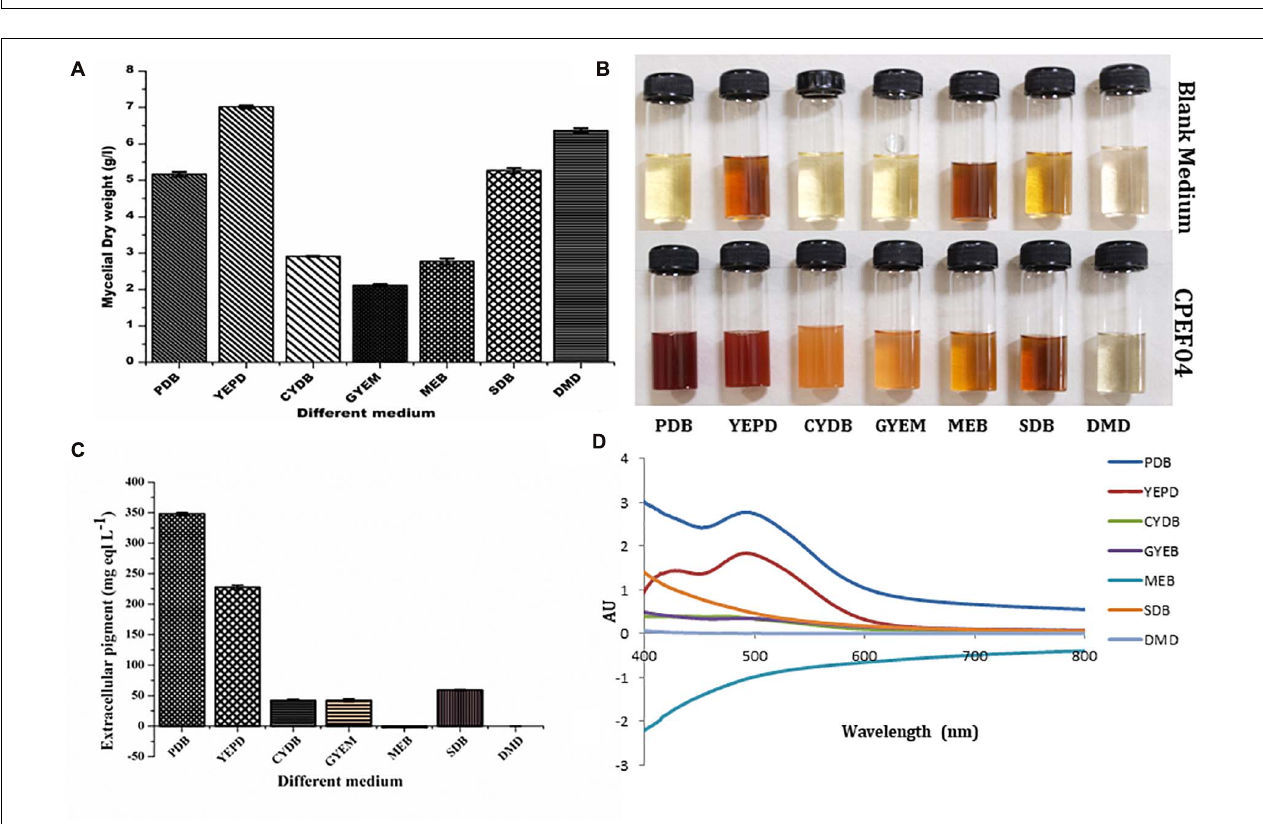
FIGURE 5 | Effect of different media composition on the biomass (A) and extracellular pigment production (B,C) by CPEF04 isolates. Effect on UV–visible absorption spectra of mycelium filtrate cultured on different media (D)